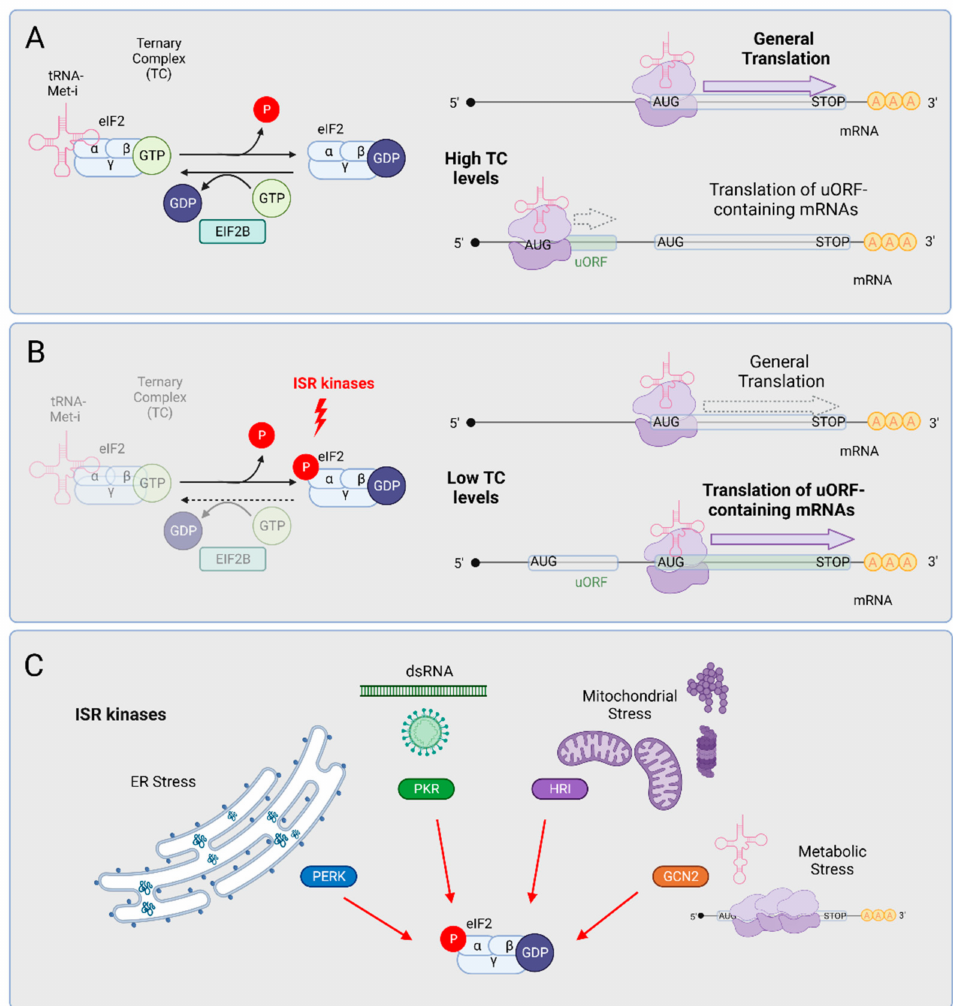
Figure 2. ISR kinases reprogram cellular translation by regulating TC levels through eIF2 α phos- phorylation. ( A ) After translation initiation, eIF2B recycles the eIF2 complex by exchanging GDP by GTP and favoring high TC levels. Under this situation, the translation of most mRNAs (general translation) is promoted and on the contrary, uORFs-containing mRNAs translation is non-favored. ( B ) Under stress conditions, the ISR kinases phosphorylate the alpha subunit of eIF2, blocking the eIF2B-mediated GDP/GTP exchange. As a consequence, the recycling of the eIF2 complex is impeded and TC levels are low. In this case, general protein translation is inhibited but the translation of uORFs-containing mRNAs is favored. ( C ) Each one of the four ISR kinases is activated by a specific type of stress. Endoplasmic Reticulum (ER) stress caused by misfolded proteins activates PERK, whereas endogenous or viral double-stranded RNAs (dsRNAs) activate PKR. Cytosolic protein